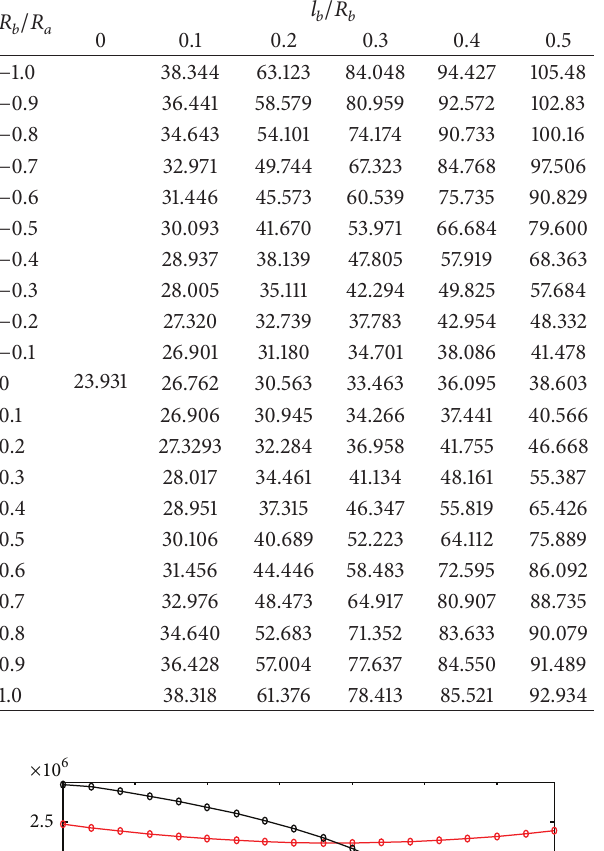
Table 6: The first frequency parameters of C-C-C-C shallow shells.